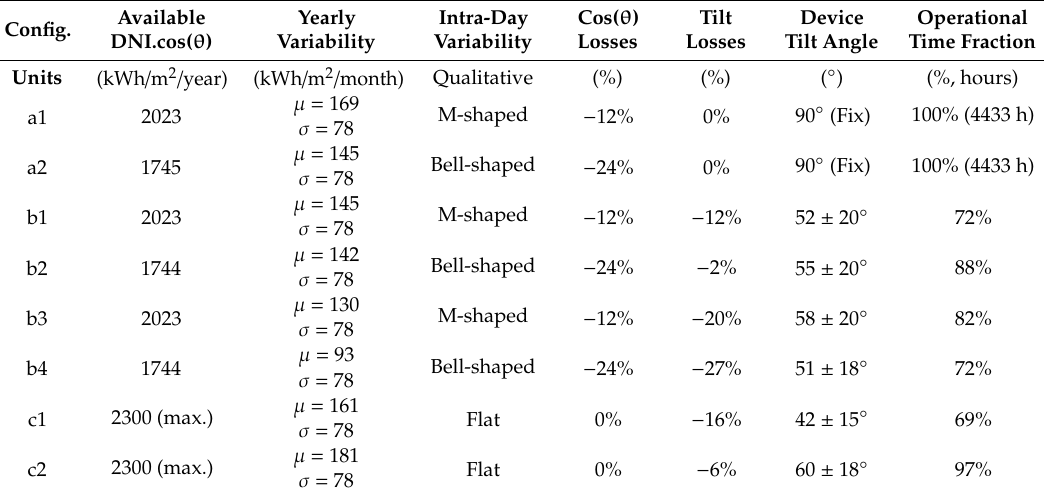
Table 6. Summary of geometrical analysis for Seville, Spain. Config.